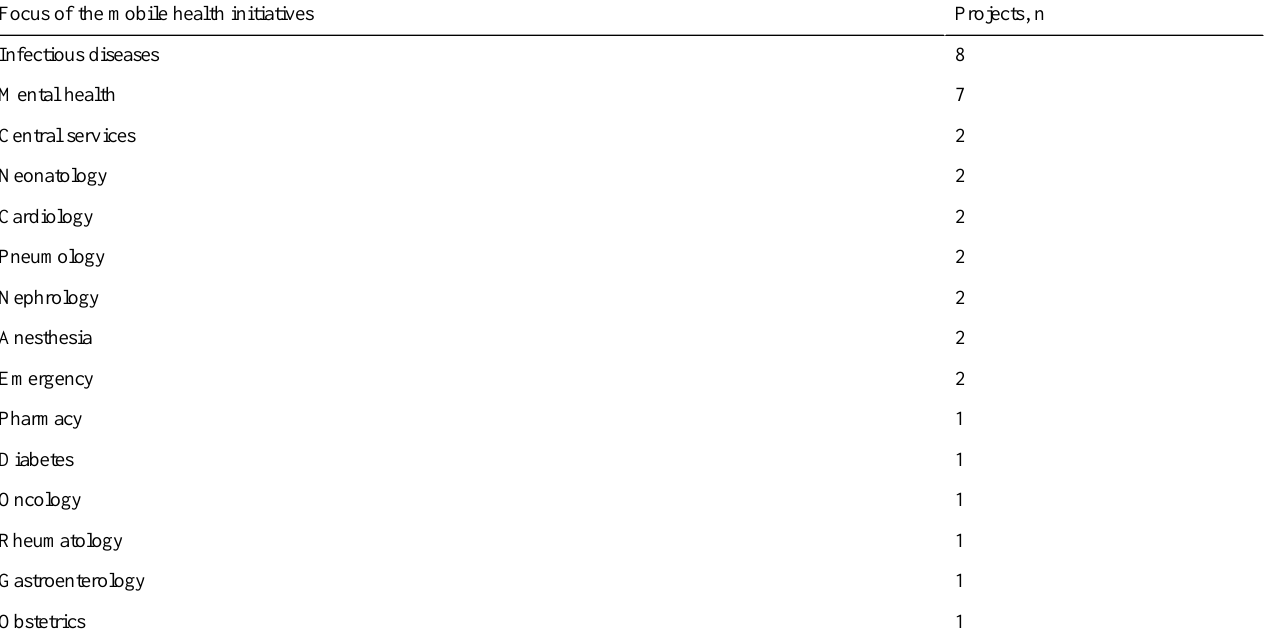
Table 1. Summary of mobile health initiatives found according to the medical specialty.